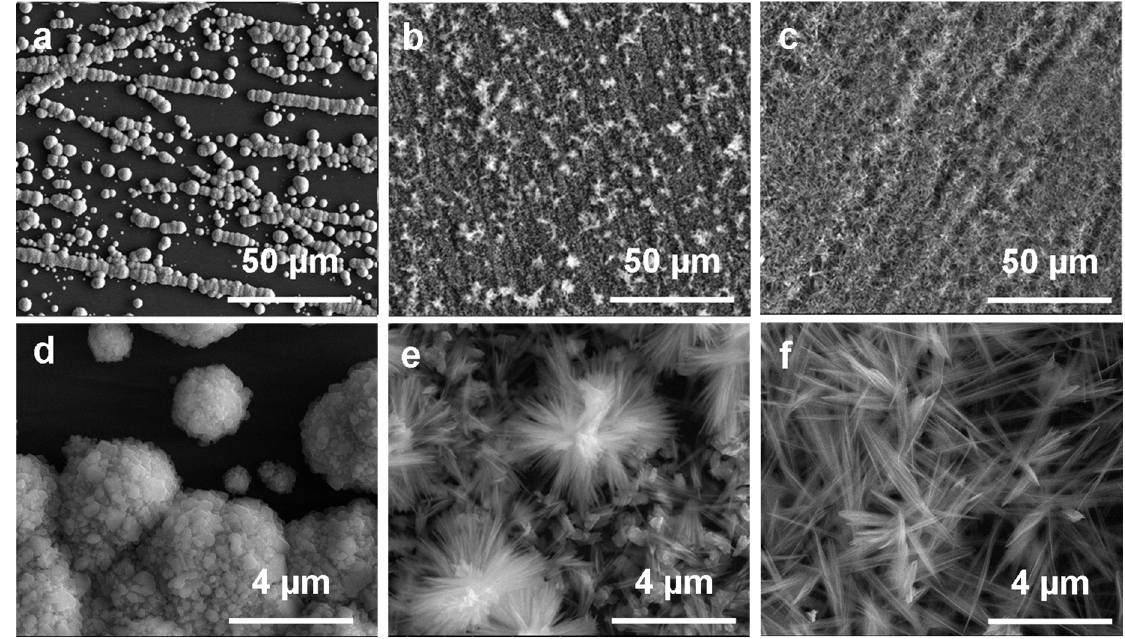
Figure 1. Scanning electron microscopy (SEM) images: ( a , d ) electrodeposited copper surfaces (3 V, 0.1 A, 30 s), ( b , e ) the same surfaces after immersion process in 0.033 M, and ( c , f ) in 0.066 M NH3 solution (48 h, partially-covered